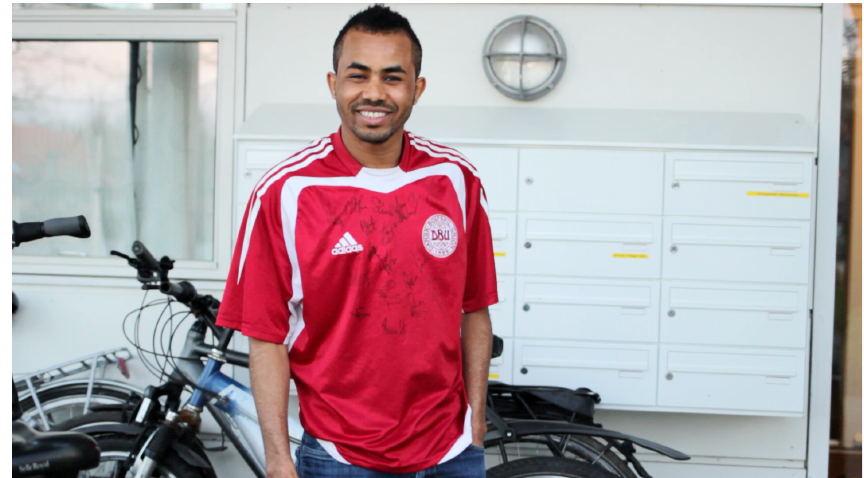
Figure 18. Ermiras wearing a t-shirt of the Danish national football jersey signed by all the players. May